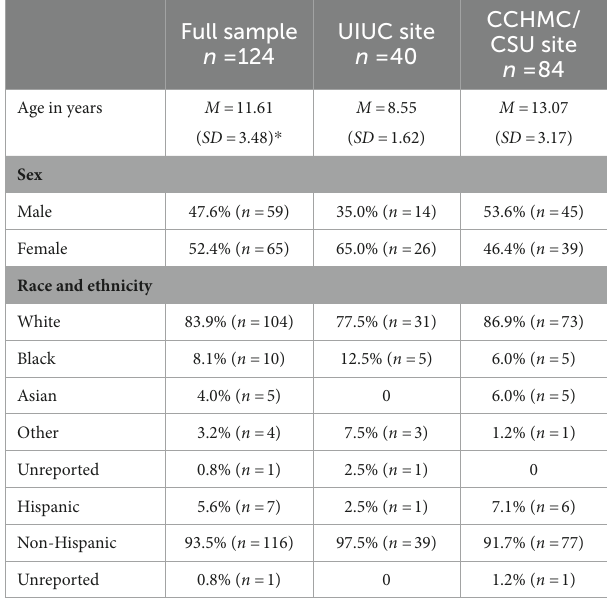
TABLE 1 Participant demographic